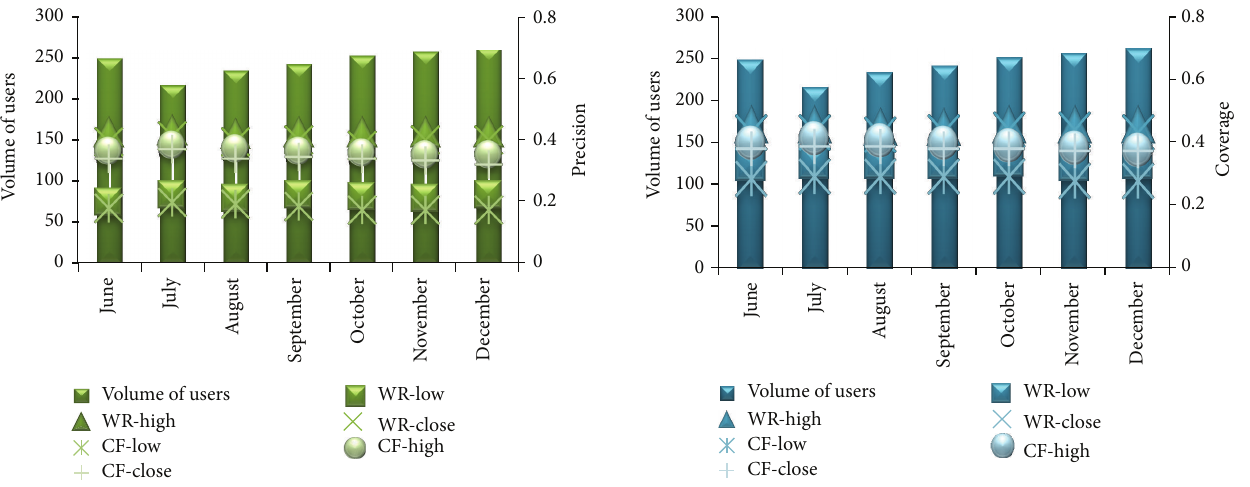
Figure 13: WebBluegillRecom-annealing system (WR) is compared to standard collaborative filtering (CF) system on precision for different volume of users in different months.